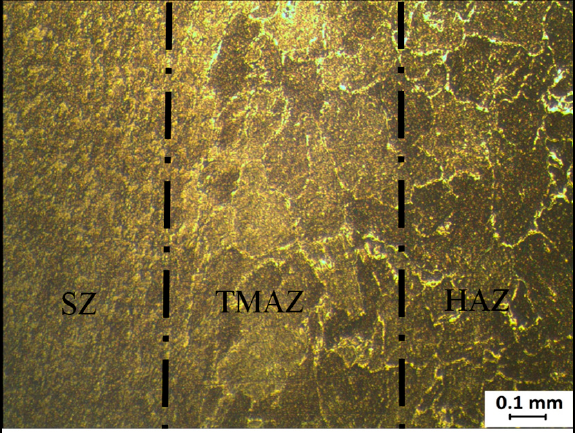
Figure 7. Microstructure of stir zone (SZ), thermo-mechanical affected zone (TMAZ), and heat-affected zone (HAZ) boundary (5×) of FSPed Sample 2.